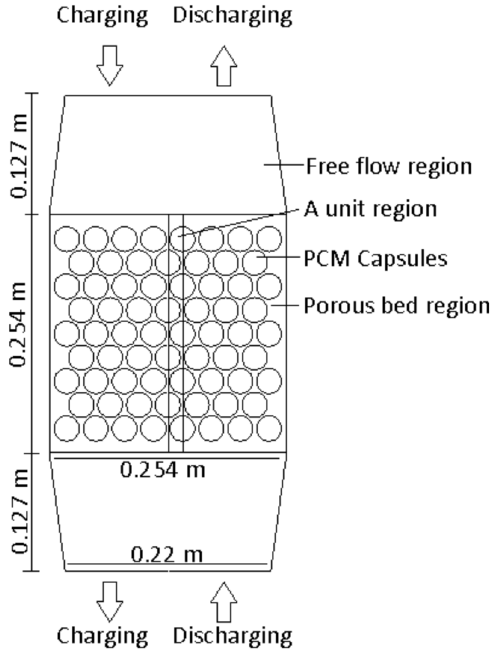
Fig. 1. Schematic of thermal energy storage